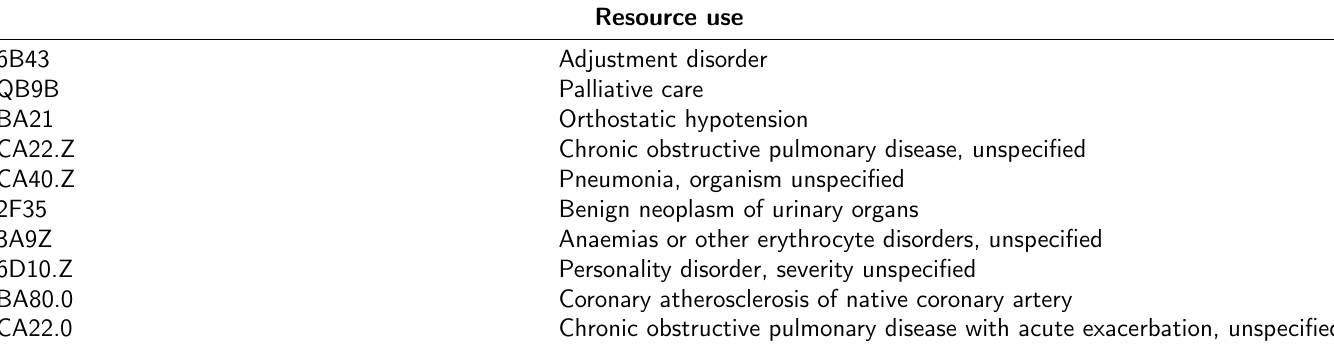
Table 5: Top 10 disagreeing conditions by ‘resource